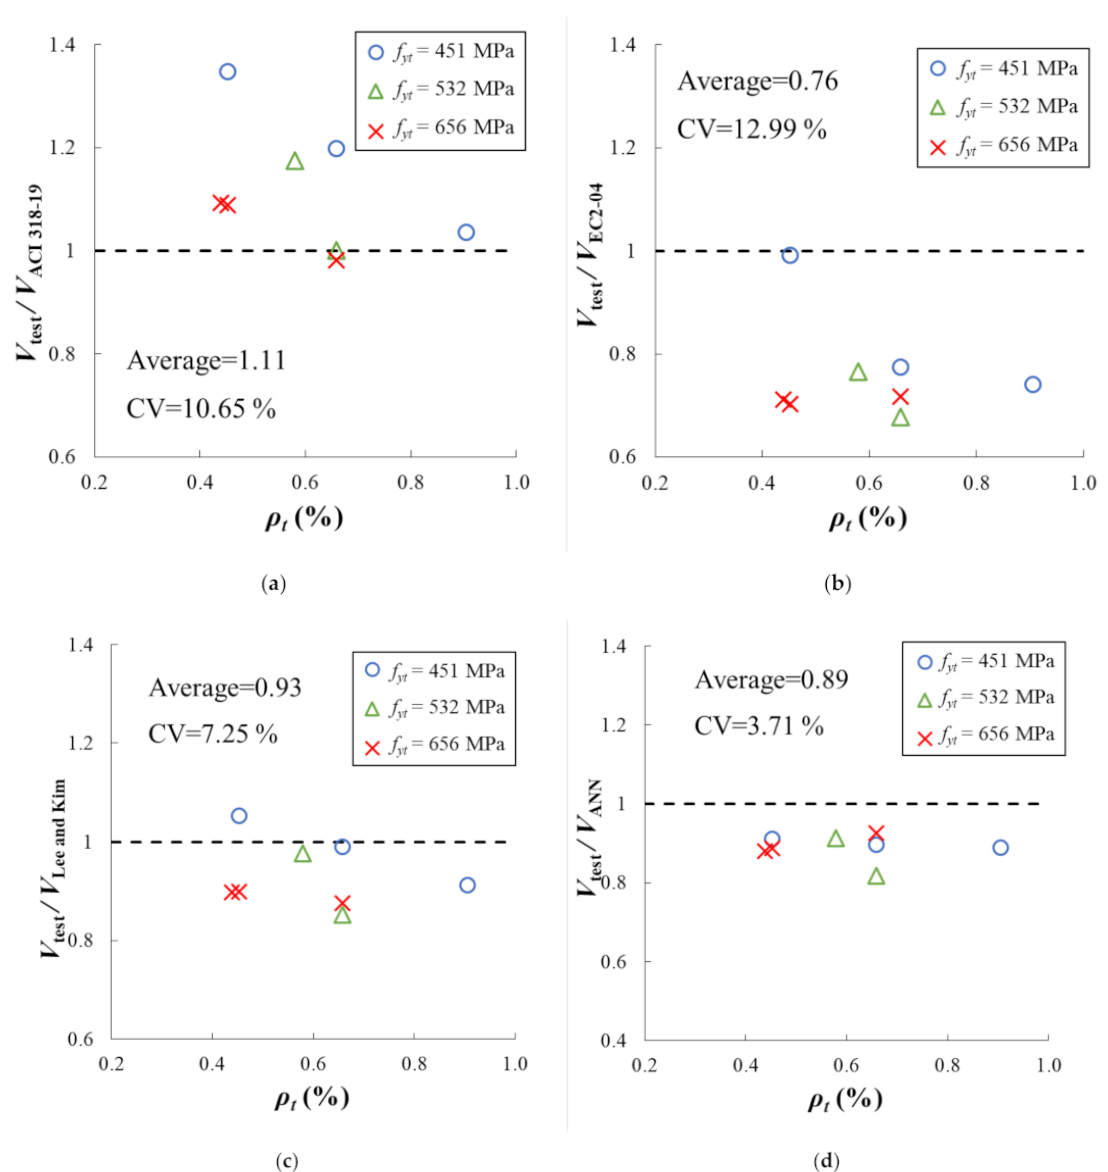
Figure 4. Validation of the four methods. The accuracy is assessed by the distances between the markers and the horizontal dashed line. ( a ) ACI 318-19; ( b ) EC2-04; ( c ) Lee and Kim; ( d ) ANN with